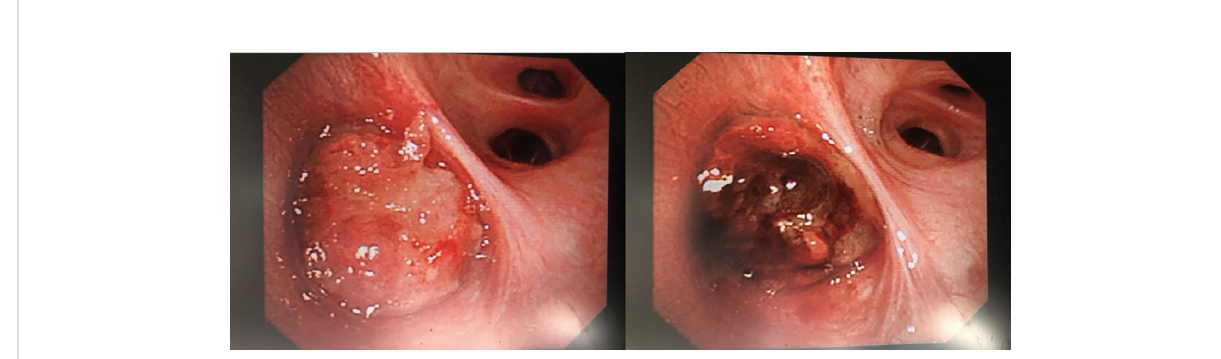
FIGURE 3 Mucoepidermoid carcinoma seen under fi breoptic bronchoscopy. Rigid bronchoscopy + electronic tracheoscopy: irregular new organisms can be seen at the opening of the right middle lobe, bad and dead objects and purplish red blood vessel attachment can be seen on the surface, which easily bleeds and blocks the ori fi ce, and the distal end cannot be penetrated. More than 10 new bioelectric trap biopsies and frozen biopsies in the right middle lobe were sent for pathological biopsy. After the operation, the original right middle lobe was blocked, and the opening was partially unobstructed. The volume of intraoperative local bleeding was approximately 50 ml. No active bleeding was found after endoscopic haemostasis.